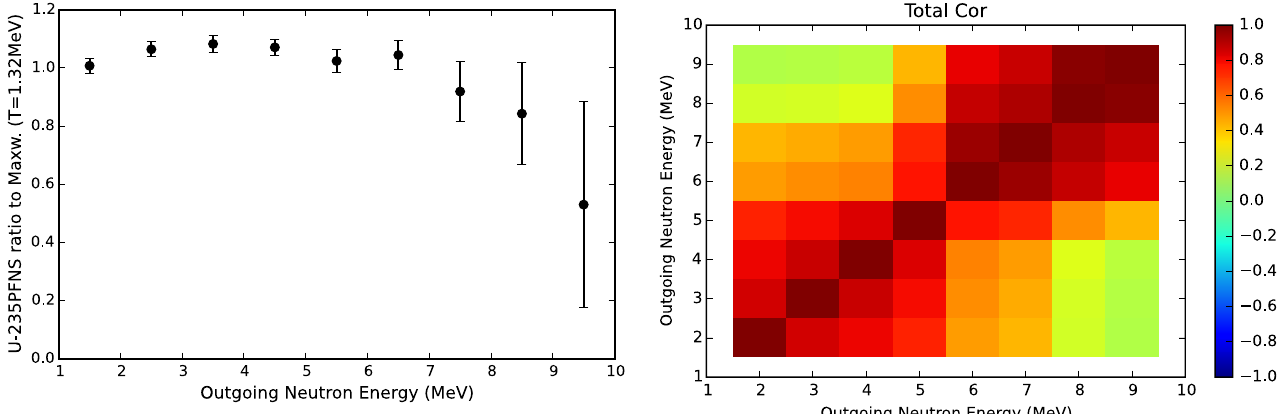
Fig. 3. A plot of Lestone et al. PFNS data with total 1-sigma uncertainties estimated by ARIADNE using the input deck in Figure 2 is shown as automatically generated by the program.